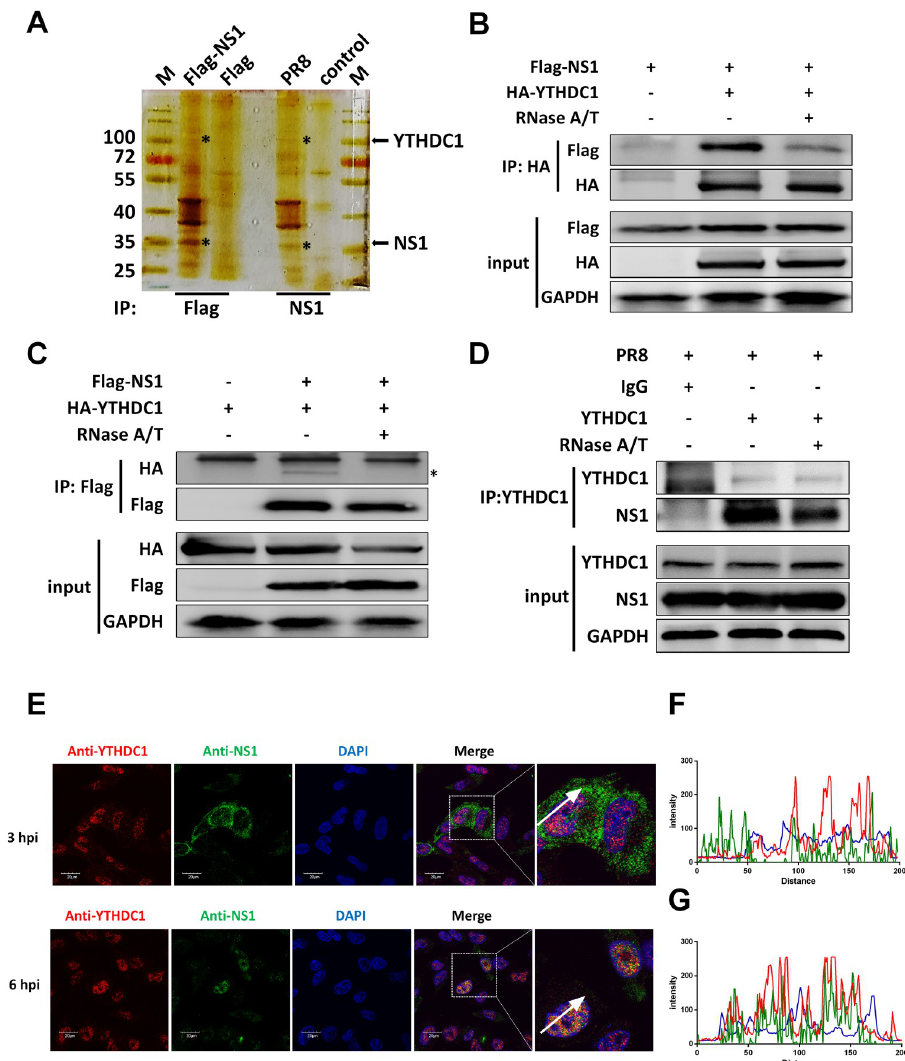
Fig 1. NS1 associates with YTHDC1. (A) HEK293T cells were infected with PR8 virus at a multiplicity of infection (MOI) of 0.01 or transfected with Flag-NS1 and vector for 24 hours, cell lysates were immunoprecipitated with an anti- Flag or anti-NS1 antibody and then analyzed by silver stain. (B-C) HEK293T cells were transfected with the indicated plasmids for 24 h. The cell lysates were treated with or without 100U RNase A/T at 37˚C for 30 min. CoIP assay was performed using an anti-HA (B) and anti-Flag (C) antibody and analyzed by western blotting. (D) A549 cells were infected with the PR8 virus at an MOI of 0.01 for 24 hours. The cell lysates were treated with or without 100U RNase A/T at 37˚C for 30 min. CoIP assay was performed using an anti-YTHDC1 antibody. Input and IP complexes (NS1 and YTHDC1) were analyzed by western blotting. (E-G) A549 cells were infected with the influenza virus at MOI of 5. Cells were fixed and analyzed for the colocalization of YTHDC1 with NS1 after 3 and 6 hours post infection. Scale bar, 20 μ m. (F and G) The normalized fluorescence of YTHDC1 and NS1 along the white arrowheads shows overlapping